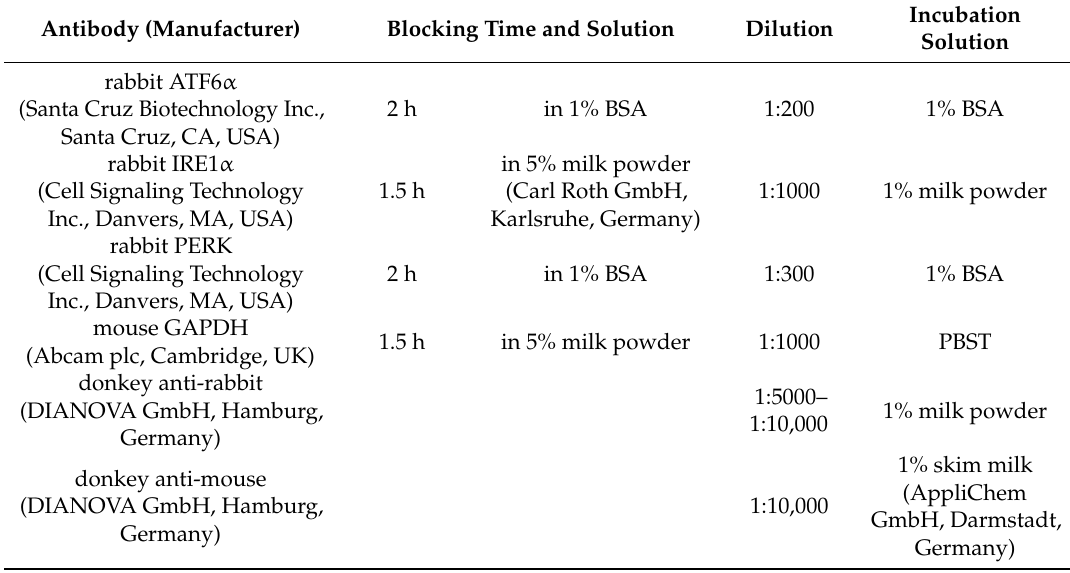
Table 2. Antibodies for Western